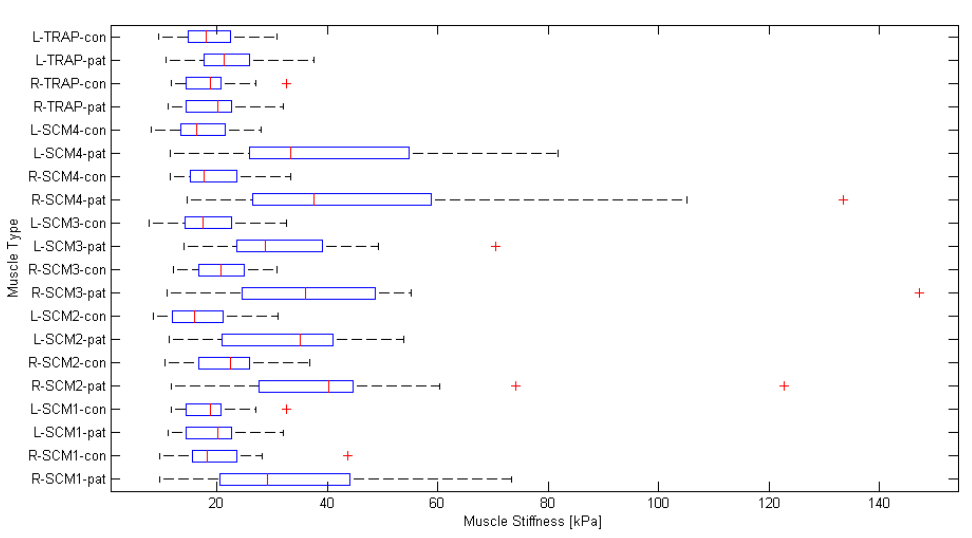
Fig. 3. An overview of the distribution of muscle stiffness values. Left-hand side (L) and right-hand side (R), patients (pat) and controls (con); the four locations at the sternocleidomastoid muscle (SCM) are described in the Introduction section; TRAP stands for the trapezius muscle. The red line denotes the median, boxes extend from 25% to 75% quantiles, and outliers are marked by a cross.